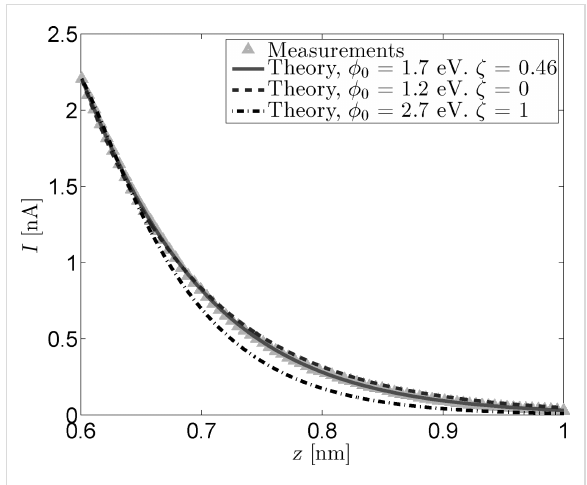
Figure 2: Measured and reconstructed I ( z ) data. The reconstructed traces were based on the fit parameters from Figure 1. All curves have been normalized to have a starting point of 2.2 nA at z 0 = 0.6 nm.